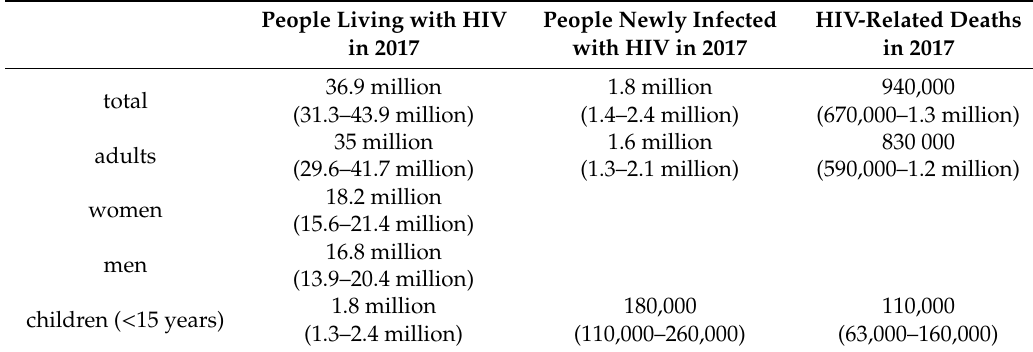
Table 1. Summary of the global human immunodeficiency virus (HIV) epidemic (2017) according to World Health Organization (WHO) data.